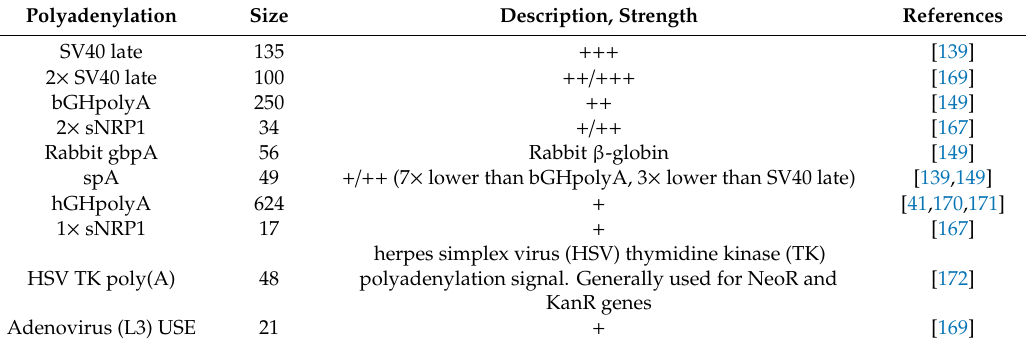
Table 5. Polyadenylation